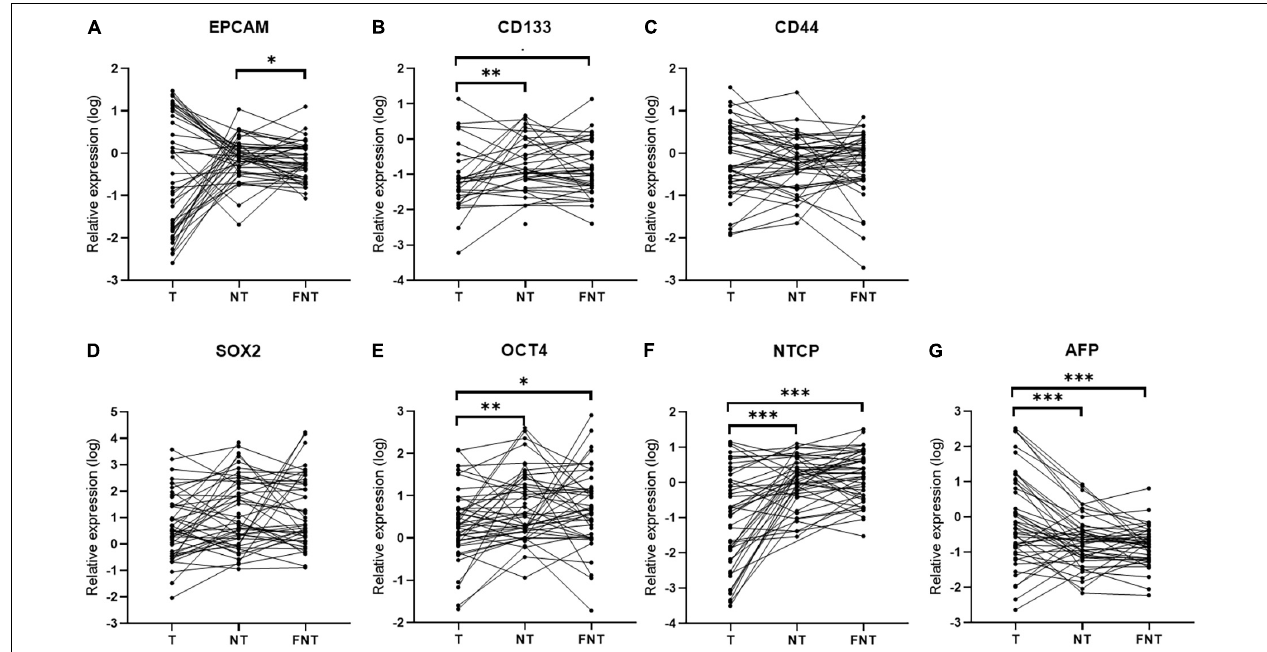
FIGURE 4 | Cancer-related markers expression in T, NT, and FNT samples. Dot plots of (A) EPCAM, (B) CD133, (C) CD44, (D) SOX2, (E) OCT4, (F) NTCP, and (G) AFP. Statistical analysis was performed by Wilcoxon signed rank test. ∗ p < 0.05; ∗∗ p < 0.01; ∗∗∗ p < 0.001. EPCAM, epithelial cell adhesion; AFP, alpha fetoprotein; OCT4, octamer-binding transcription factor 4; NTCP, sodium taurocholate cotransporting polypeptide.